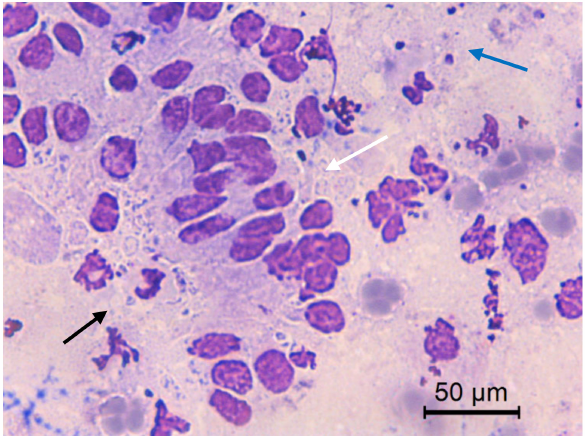
Figure 11. Jenny’s endometrial cytology collected by CB in estrus. Distorted endometrial epithelial cells (white arrow). Clear background, degenerate PMNs (black arrow), RBC, debris and bacteria (blue arrow) are present. Modified Wright’s stain 400 ×